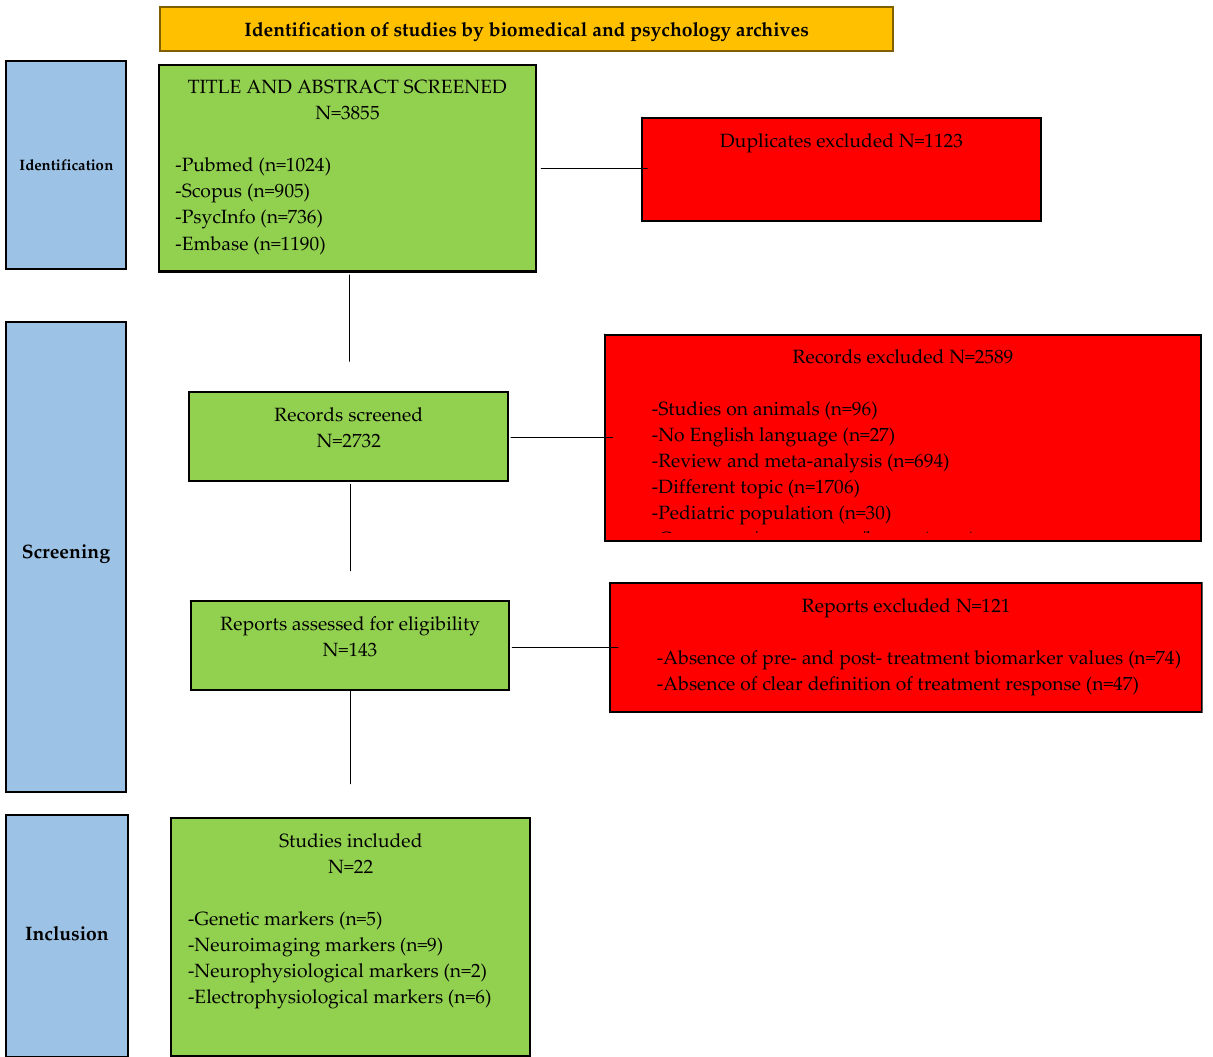
Figure 1. PRISMA flowchart for systematic reviews.